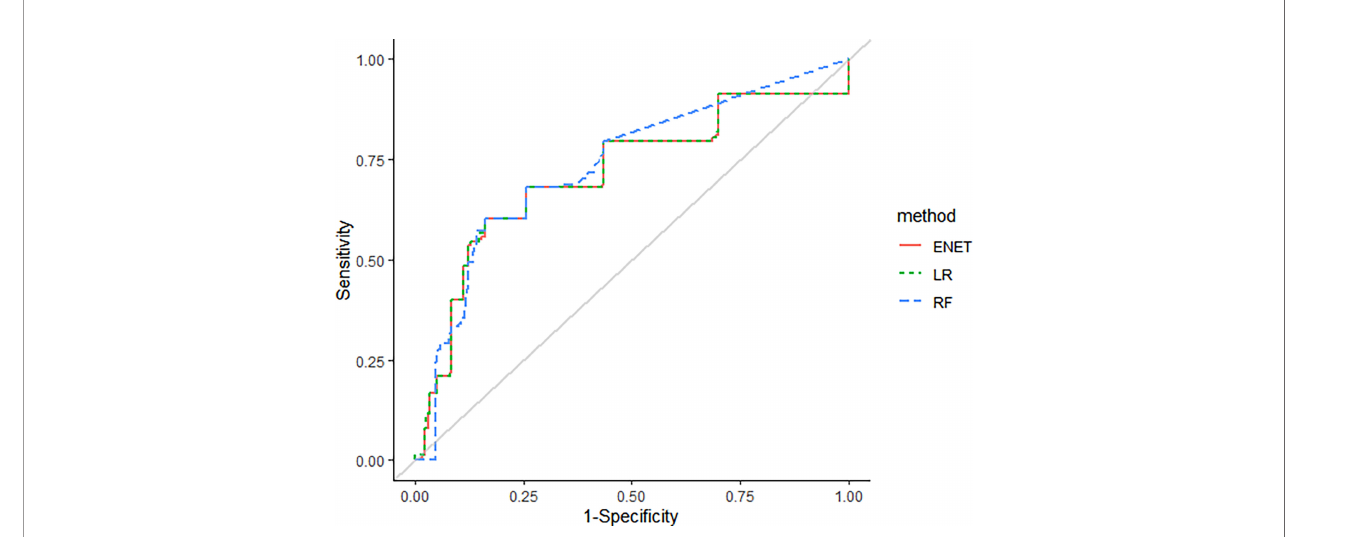
FIGURE 1 | The receiver-operating curves (ROC) for fi ve-fold cross-validated multivariate logistic regression, elastic net, and random forest (RF).